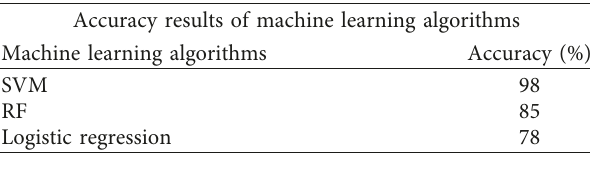
Table 1: Accuracy of machine learning algorithms.